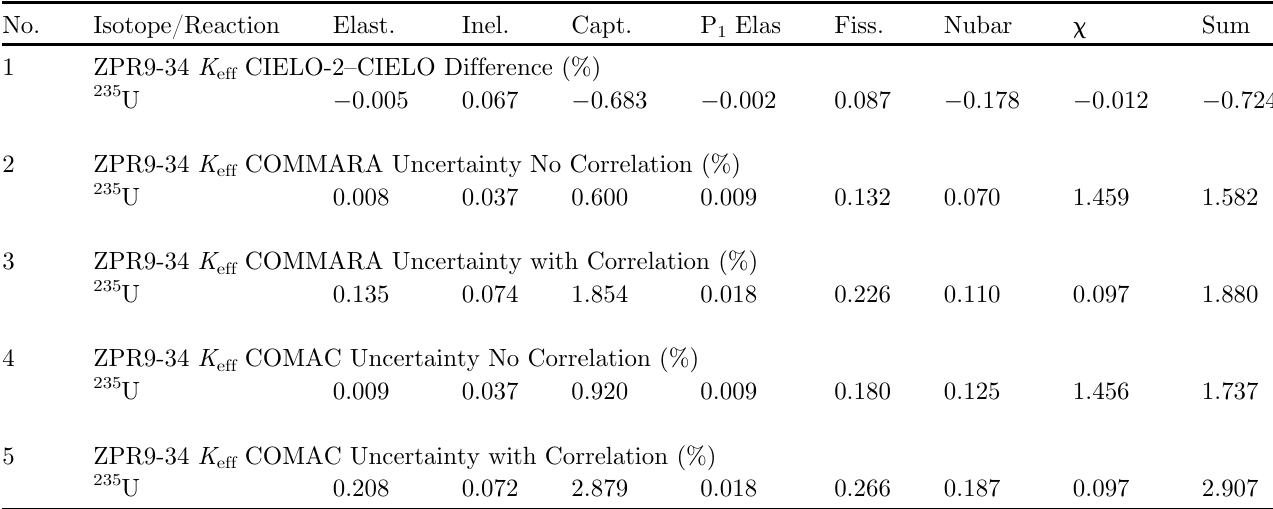
Table 4. (C-E)/E of CIELO and CIELO-2 235 U and consistency with uncertainty of COMMARA 2.0 and COMACV1: ZPR9-34. No. Elast. Inel.